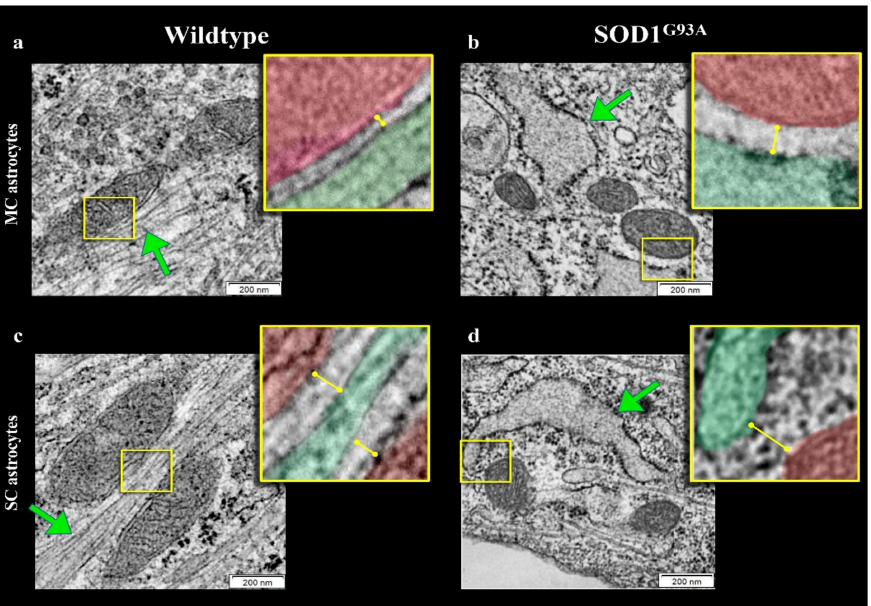
Figure 5. Electron microscopy images of ER–mitochondria networking. Representative electron microscopy images of motor cortex (MC) astrocytes harvested from wildtype ( a ) and SOD1 G93A mice ( b ) and astrocytes isolated from spinal cord (SC) of wildtype ( c ) and mutated ( d ) mice. Mitochondria and ER profiles are marked in red and green,